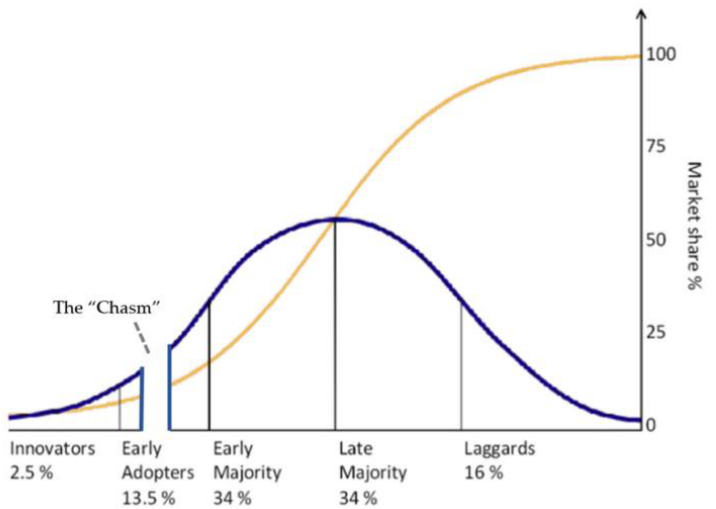
Figure 1. The course of adoption of innovations in time for individual categories of adopters. Source: cited from Brdulak, Chaberek and Jagodziński (2021) [33]. Table 2. Category of Diffusion model